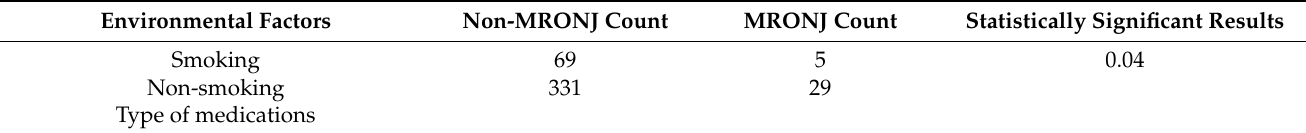
Table 3. A summary of results about MRONJ risk development considering the primary ARD taken and the main adjunctive